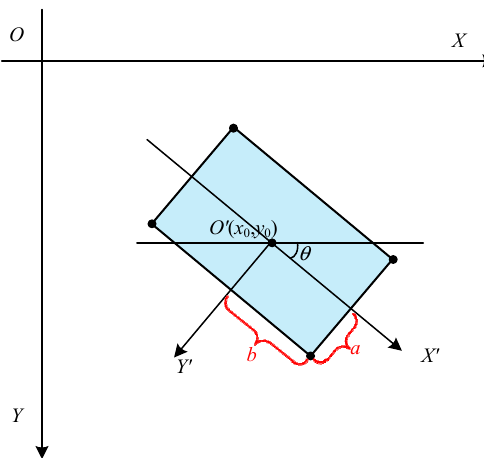
Figure 2. A schematic diagram of the direction of an